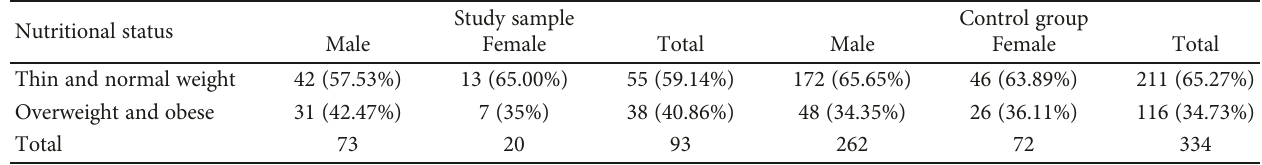
Table 1: Nutritional pro fi les of the study sample and the control group .